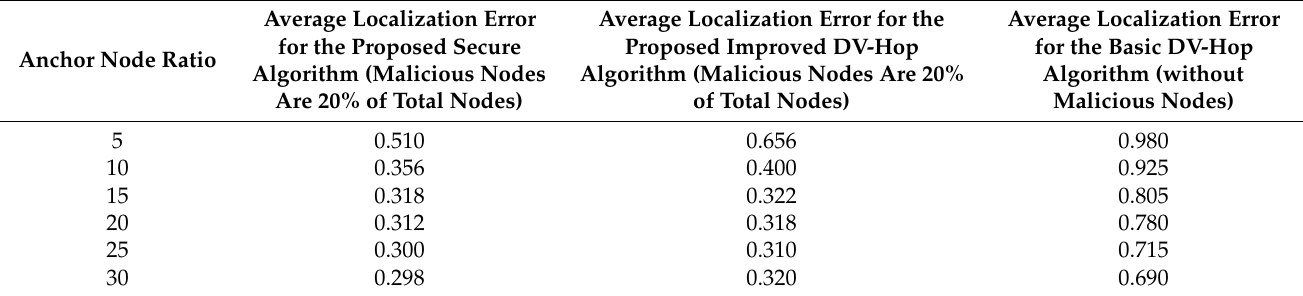
Figure 10. Error with the changing anchor number under the impact of malicious nodes. Table 7. Average localization error variation corresponding to the anchor node number with and without malicious nodes for the proposed algorithm and other variants.